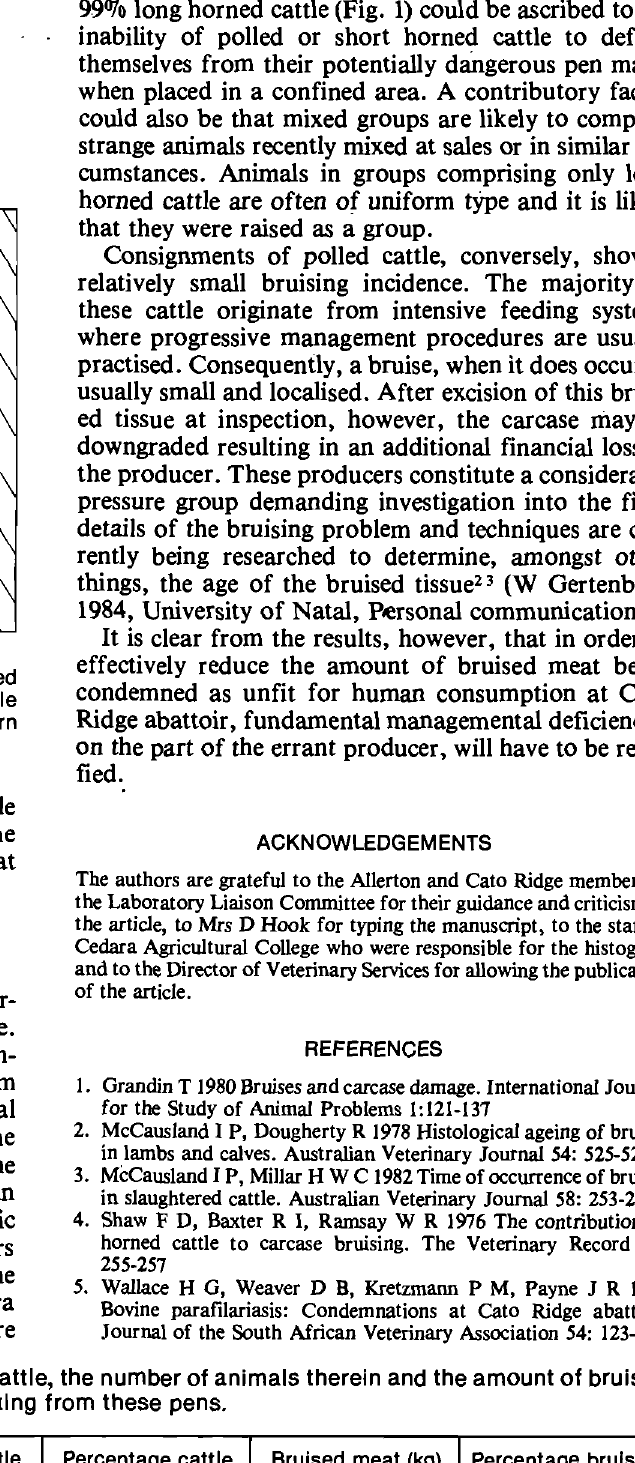
Table 2: The number of pens with and without Type 3 cattle, the number of animals therein and the amount of bruised Pen composition Number of pens Number of cattle Percentage cattle Bruised meat (kg) Percentage bruised Pens containing Type 0, 1 and/or 2 cattle only 904 16,7 Pens containing Type 3 cattle either mixed with others ora/one 635 Total 1539 TYDSKRIF. V AN DIE SUIO-AFRlKAANSE VETERIN£RE VERENIGING - DESEMBER 1985